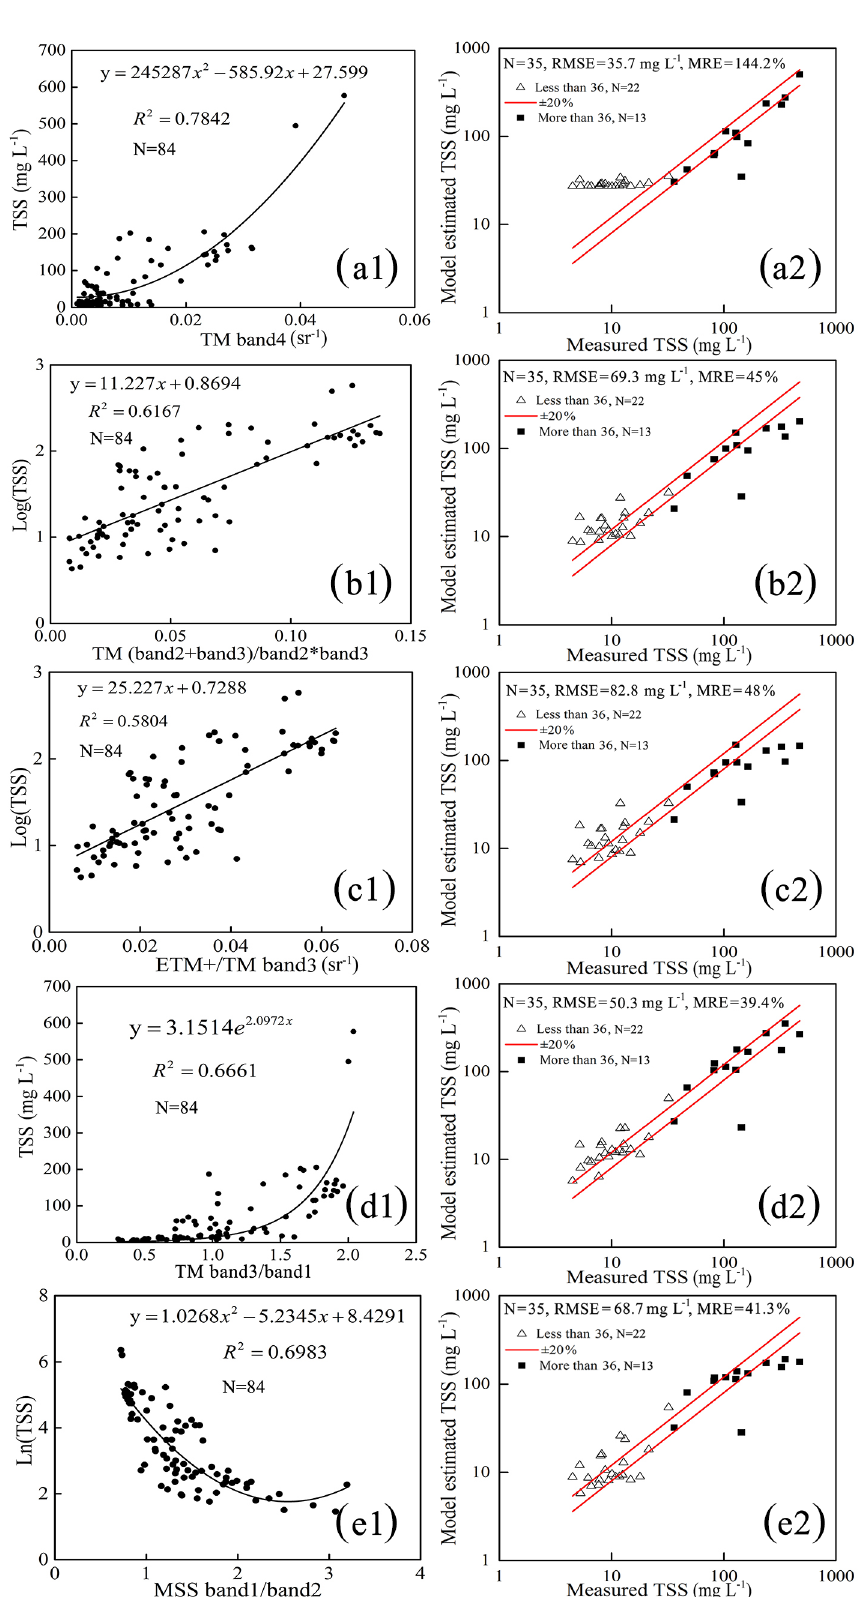
Figure 3. The recalibration and validation of previous five TSS retrieval models based on 119 in situ samples. The models were developed by (a) Chen et al. (2014), (b) Li et al. (2010), (c) Zhang et al. (2014), (d) Lathrop et al. (1991), (e) Ritchie and Cooper (1991),